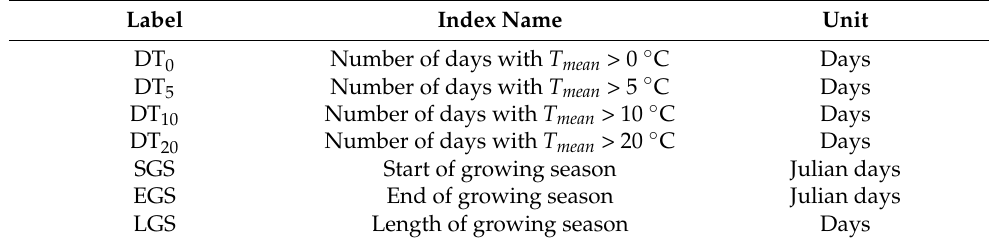
Table 1. The bio-temperature indicators used in this study.